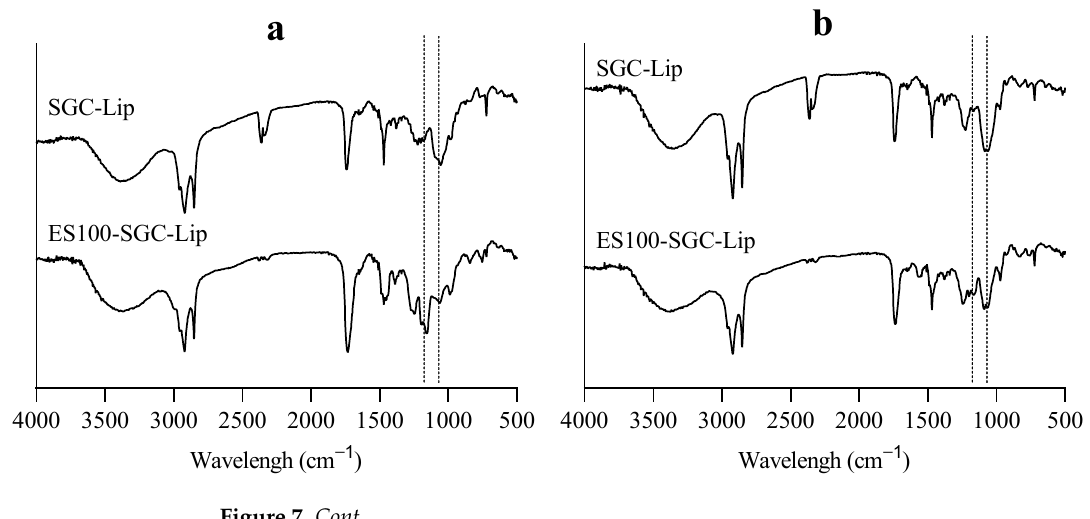
Figure 7. FTIR spectra of SGC-Lip and ES100-SGC-Lip obtained after 2-h incubation at 37 °C in ( a ) SGC pH 1.2, ( b ) FaSSIF pH 6.5, ( c ) FeSSIF pH 5, ( d ) PBS pH 7.4. Figure 8. TEM images ( a ) SGC-Lip in SGF, ( b ) ES100-SGC-Lip in SGF, ( c ) SGC-Lip in FaSSIF, ( d ) ES100-SGC-Lip in FaSSIF, (e) SGC-Lip in FeSSIF, ( f ) ES100-SGC-Lip in FeSSIF, ( g ) Lip in FeSSIF, ( h ) ES100 -Lip in FeSSIF, ( i ) SGC-Lip in PBS pH 7.4, ( j ) ES100-SGC-Lip in PBS pH 7.4 after 2-h incubation at 37 °C.